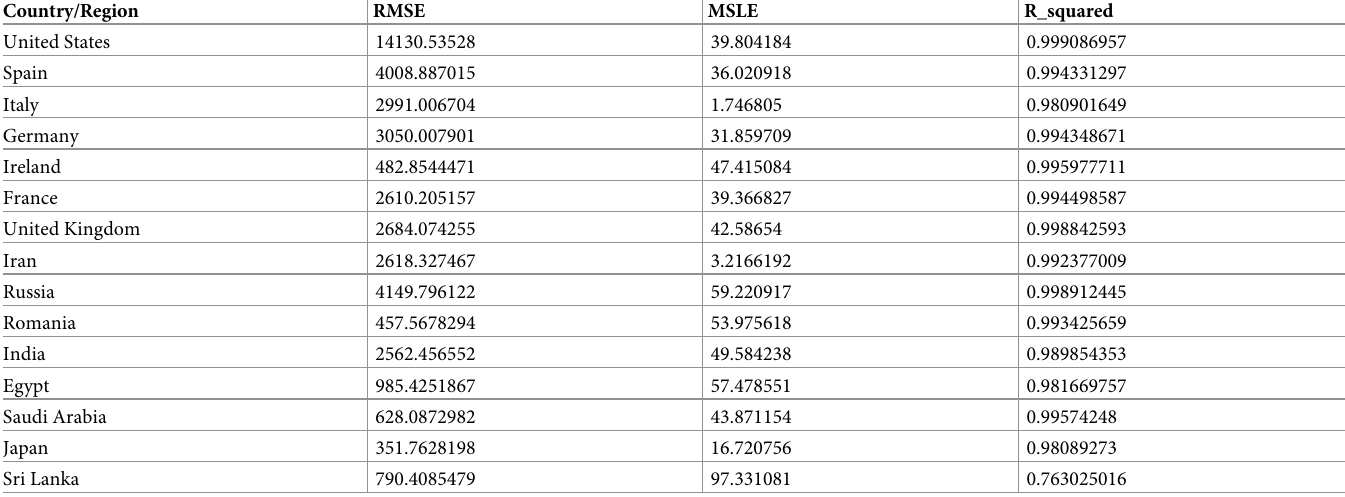
Table 2. Prediction evaluation of selected countries with one-step